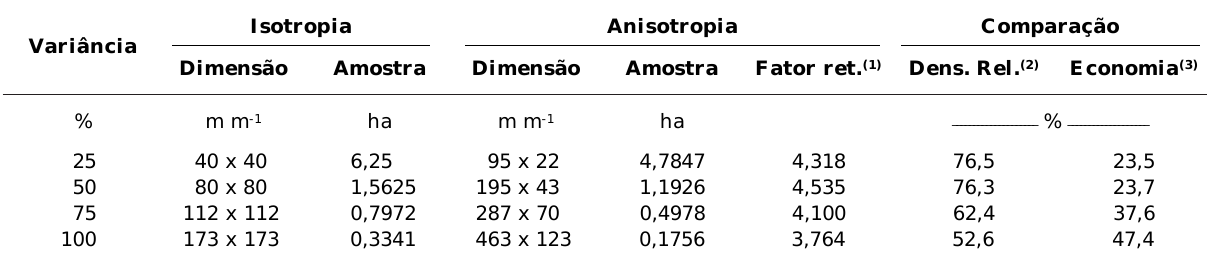
isotrópico. (3) Economia da amostragem anisotrópica.